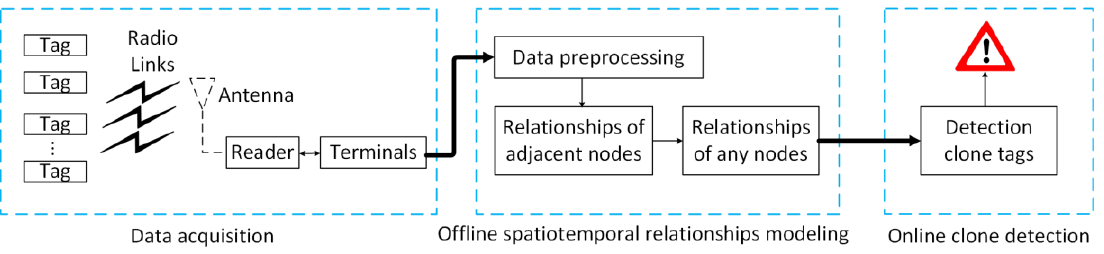
Figure 2. Flowchart of the detection method.